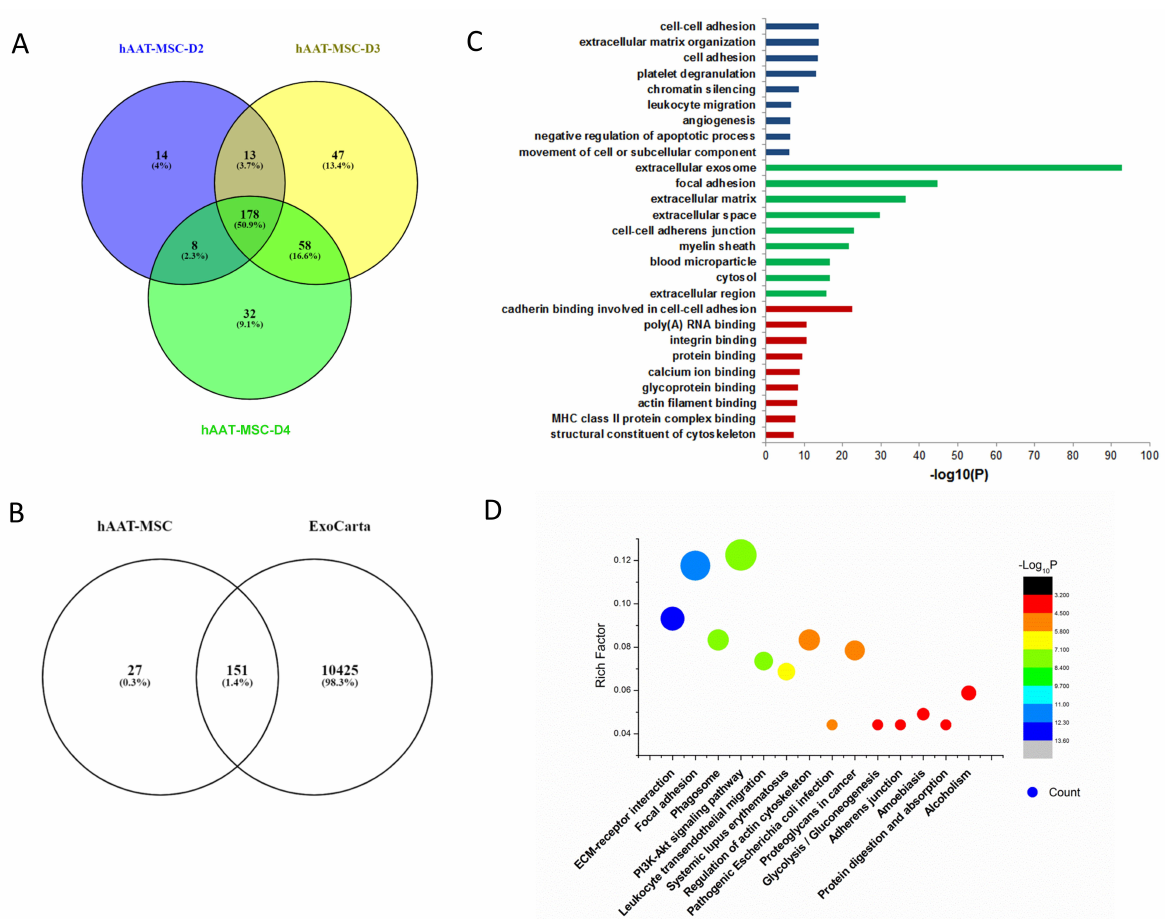
Figure 3. Bioinformatic analysis of hAAT-MSC exosomes. ( A ) Venn diagram of exosomes derived from three hAAT-MSCs cell lines. ( B ) Venn diagram of hAAT-MSC exosomes against ExoCarta. ( C ) Gene Ontology analysis of hAAT-MSC exosomes. ( D ) KEGG analysis of hAAT-MSC